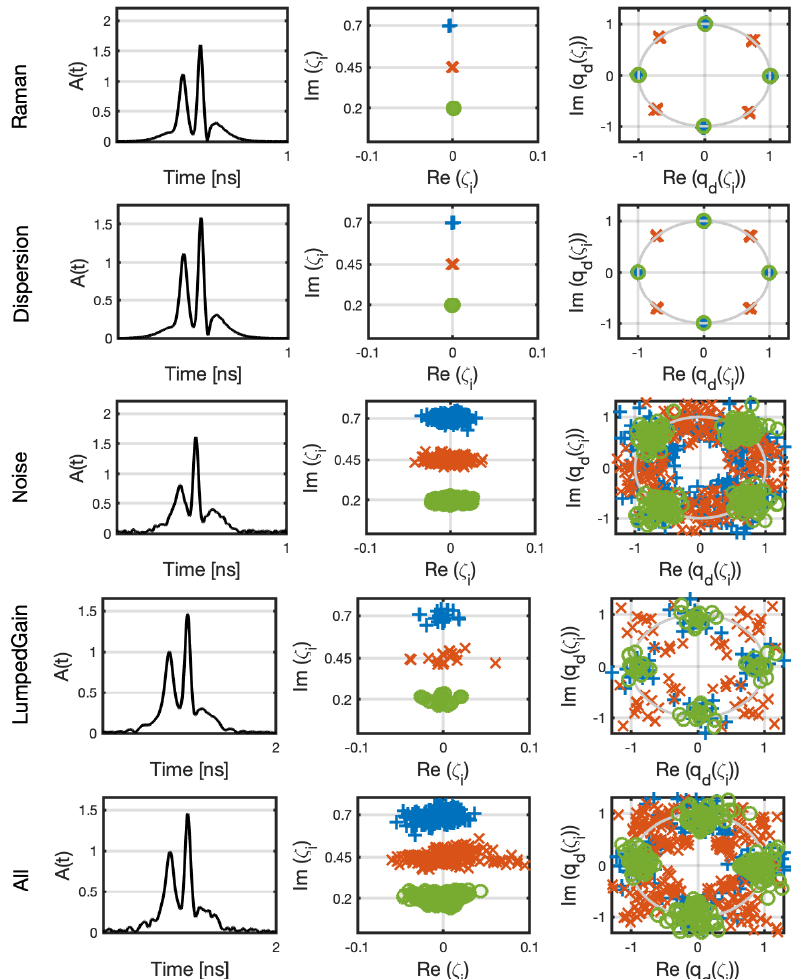
Figure 18. Simulation results with 1600 km of propagation distance and 0 dBm of launch power for third-order solitons. These results were obtained with a symbol period equal to T S2 . The first column shows a waveform of a sampled symbol of the transmitted sequence for each effect, respectively. The second column shows the received eigenvalues. The third column shows the normalized received spectral function constellations, q d ( ζ i ) for each of the three